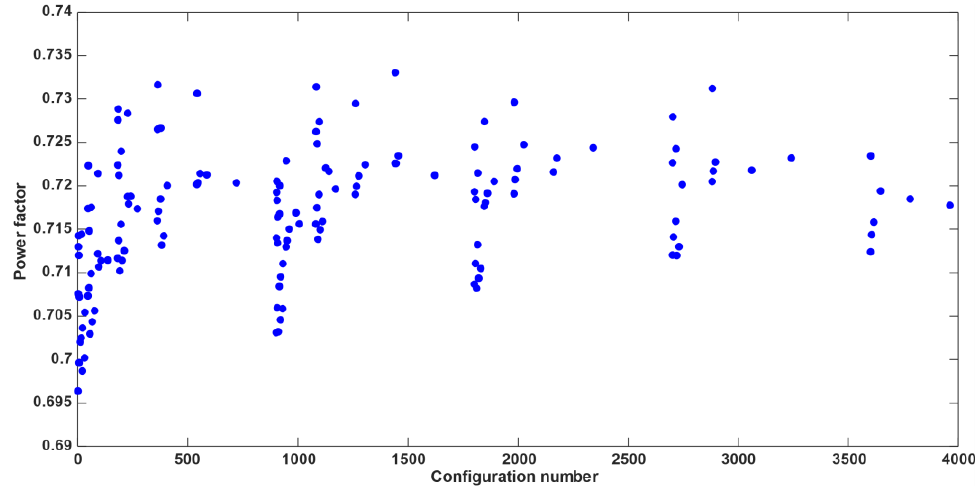
Figure 9. Values of power factor for the 154 selected configurations.